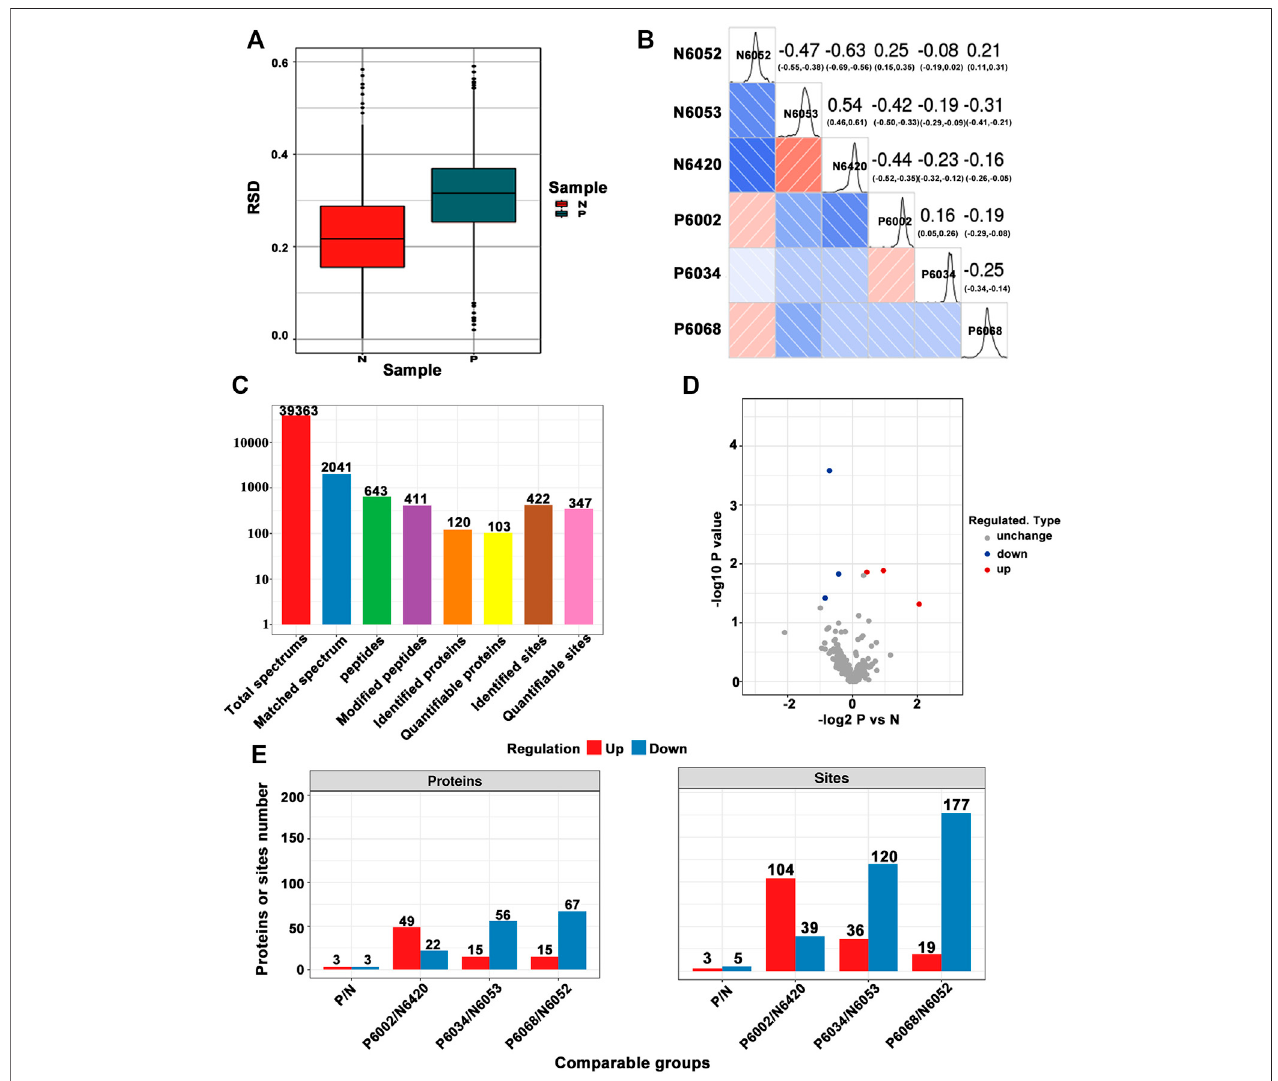
FIGURE 1 | (A) Box plot of relative standard deviation (RSD) distribution of repeated samples using quanti fi ed proteins. (B) Heat map of Pearson ’ s correlation coef fi cients from all quanti fi ed proteins between each pair of samples. (C) Basic statistical fi gure of MS/MS results. (D) Volcano plot of differentially expressed modi fi cation sites. (E) Histogram of the number distribution of differentially expressed proteins and modi fi cation sites in different comparison groups.